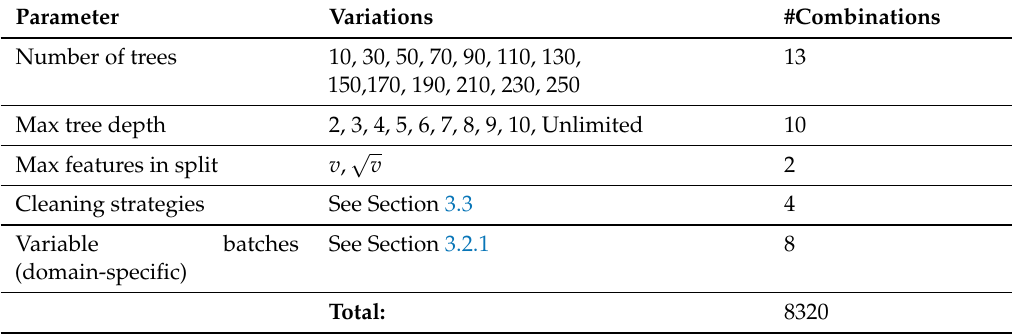
Table 5. Parameter combinations used for the RF models. Each value is separated by a comma. m is the number of input variables. Each combination of parameters represents one model